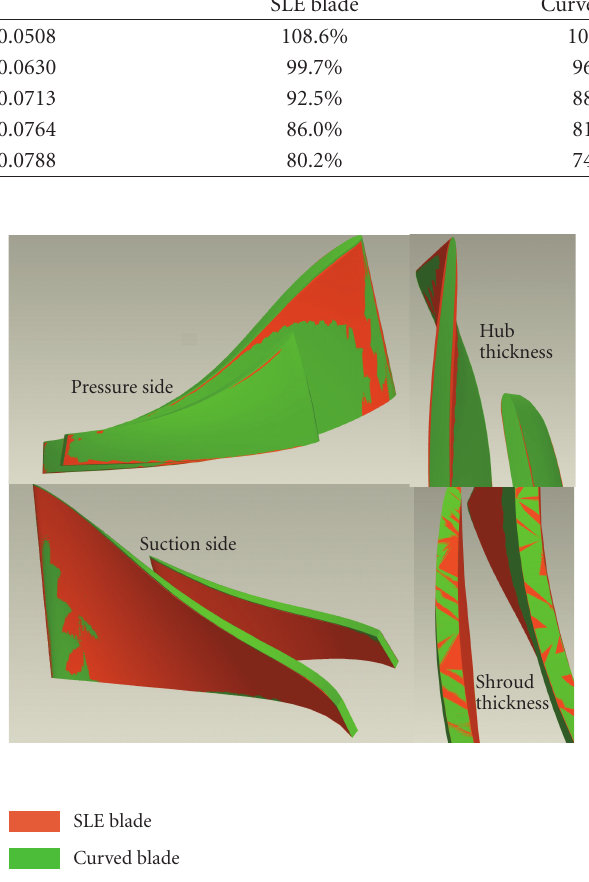
Figure 5: Visual comparison of the two impellers’ geometries.